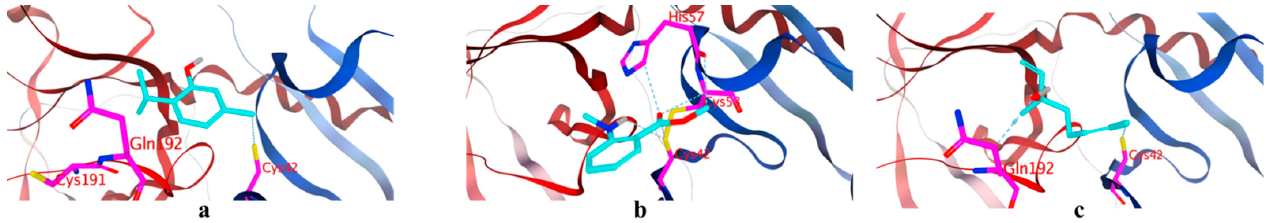
Figure 5. Binding modes of thymol ( a ), dimethyl anthranilate ( b ), and linalool ( c ) with collagenase.